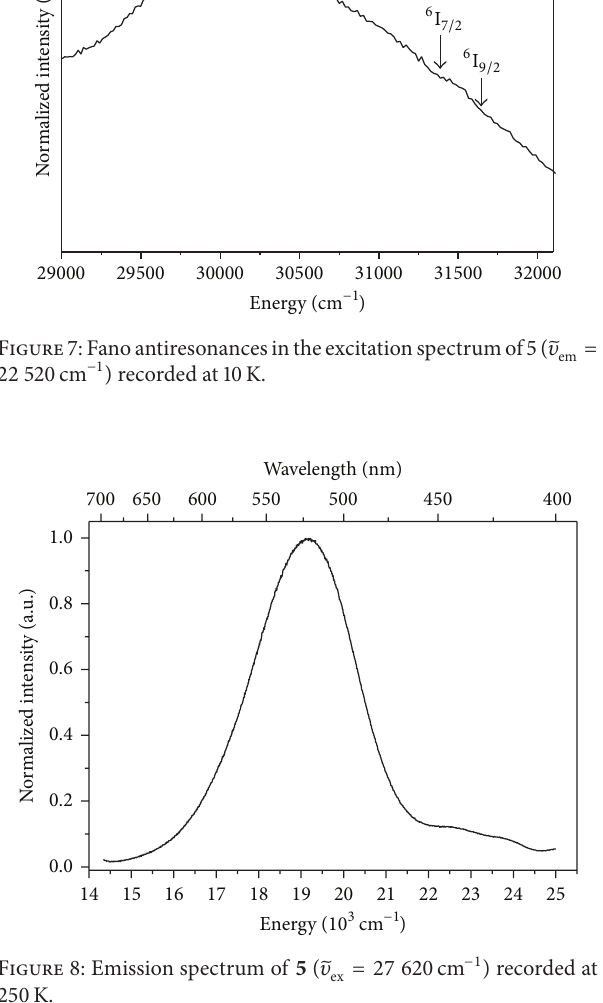
Figure 8: Emission spectrum of 5 ( ̃𝜐 250